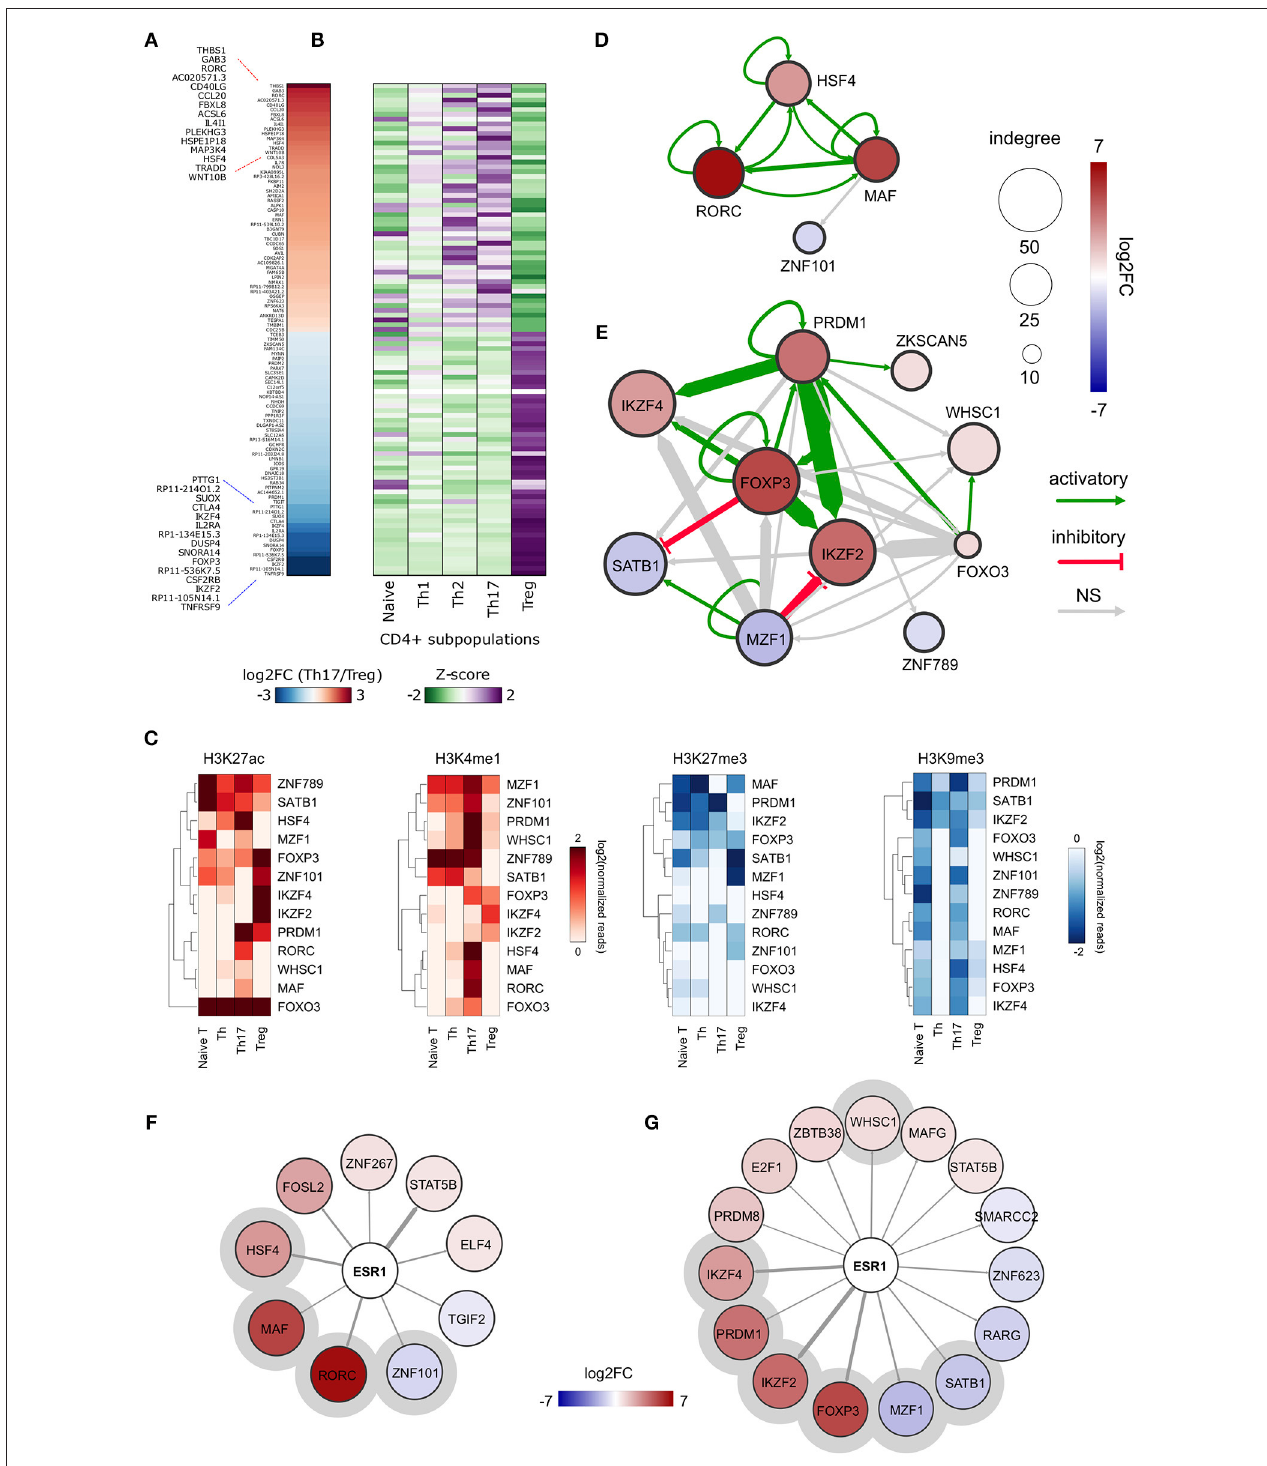
FIGURE 2 | ER α -regulated genomic regulatory regions inTh17 and Treg cells. (A) Heat map representing the log2FC of expression computed between Th17 and Treg RNA-Seq data. Only data of SE-ARRs associated significantly DE genes between the two CD4 + cell type are reported. Genes are sorted by decreasing Th17/Treg log2FC. (B) Heat map representing the gene expression specificity computed in each CD4 + population as Z-score of expression. Purple colors represent specifically overexpressed genes while green color specifically underexpressed genes. (C) Heatmap shows log2 normalized H3K27ac, H3K4me1, H3K27me3